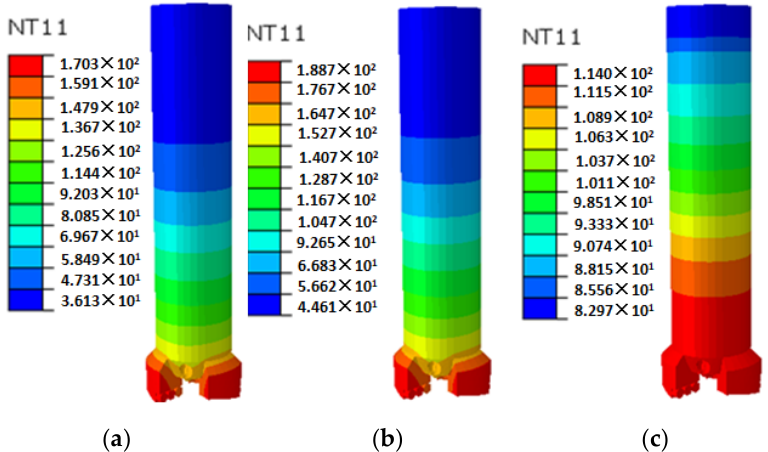
Figure 13. Temperature nephogram of core bit and core tube at core depth of 100 m in JLS: ( a ) the end of first stage; ( b ) the end of second stage; and ( c ) the end of third stage.